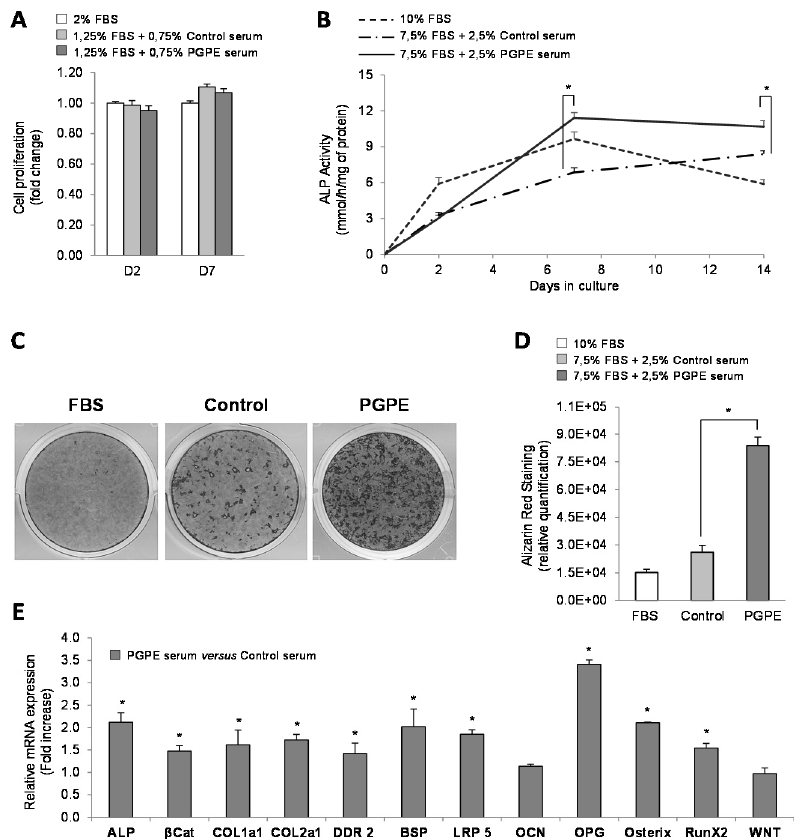
Figure 2. Osteoblast viability, differentiation and transcription in culture, after exposure to serum harvested from mice raised either under control conditions or treated with pomegranate peel extract. * p < 0.05 PGPE versus Control condition. ( A ) Cell proliferation test performed on MC3T3-E1 cells cultured in minimal medium (2% Fetal Bovine Serum, FBS), supplemented with serum from mice given either physiological serum (1.25% FBS + 0.75 Control mice serum) or pomegranate peel extract, PGPE (1.25% FBS + 0.75 PGPE mice serum), after 2 and 7 days of treatment. Results are expressed as mean ± standard error of the mean (SEM) ( n = 6). ( B ) Alkaline phosphatase, ALP activity of MC3T3-E1 cells cultured in optimized medium with 10% FBS or with 7.5% FBS + 2.5% serum from mice fed either physiological serum (Control) or pomegranate peel extract (PGPE), after 0, 2, 7 and 14 days of treatment. Results are expressed as mean ± SEM ( n = 8). ( C , D ) Mineralized nodules stained with alizarin red S on Day 21 in MC3T3-E1 cells cultured in optimized (C+) medium with 10% FBS or with 7.5% FBS + 2.5% serum from mice exposed to either physiological serum (Control) or pomegranate peel extract (PGPE). ( C ) Representative image of alizarin red staining for each condition. ( D ) Relative quantification of alizarin red staining with picture analyser software ImageJ. Results are presented as mean ± standard deviation, SD ( n = 6). ( E ) Transcriptomic analysis of the main osteoblast markers in MC3T3-E1 cells cultured in optimized medium after 7 days of treatment with serum from mice exposed to either physiological serum (Control) or pomegranate peel extract (PGPE). Transcriptomic analysis of MC3T3-E1 mRNA levels determined by Taqman Low-Density Arrays are presented as fold change compared to the Control condition (fold change = 1) as mean ± SD ( n = 6). Genes: ALP: alkaline phosphatase; β Cat: β -catenin; Coll1a1: collagen 1a1; Coll2a1: collagen 2a1; DDR2: discoidin domain receptor 2; BSP: bone sialoprotein; Lrp5; OCN: osteocalcin; OPG: osteoprotegerin; osteri RunX2 and Wnt.